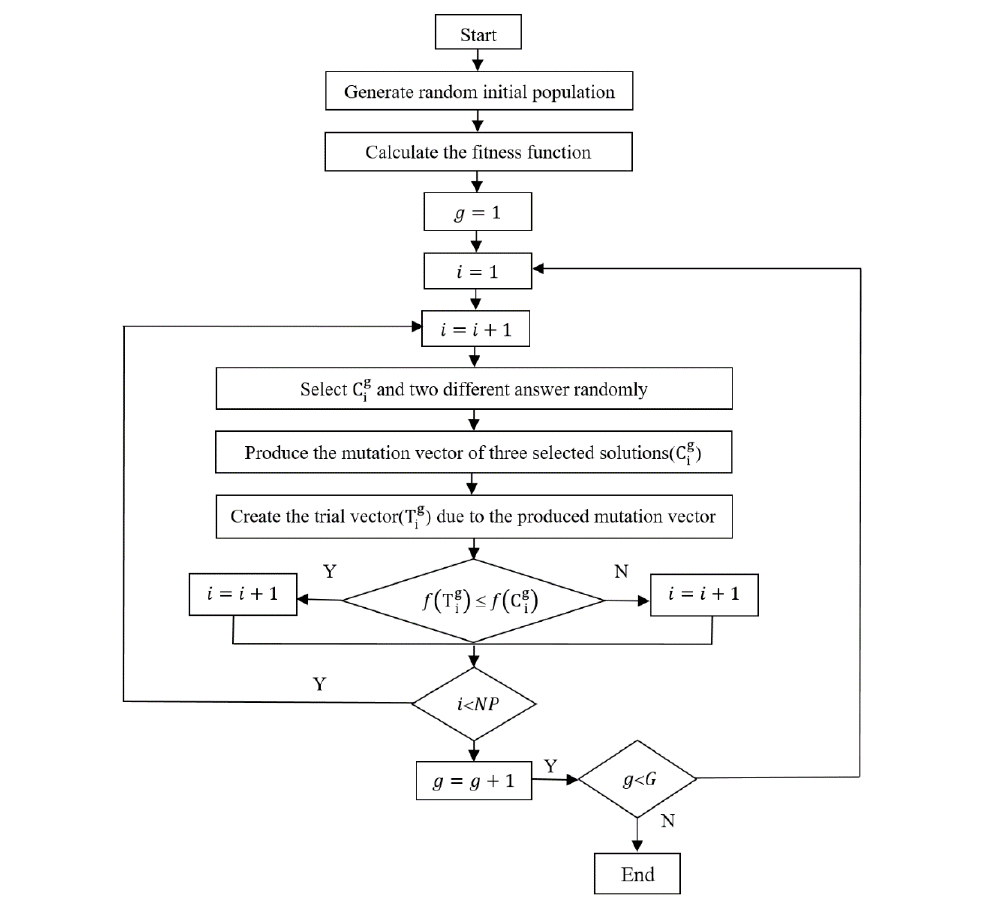
Figure 1. Flowchart of Deferential Evolution (DE).